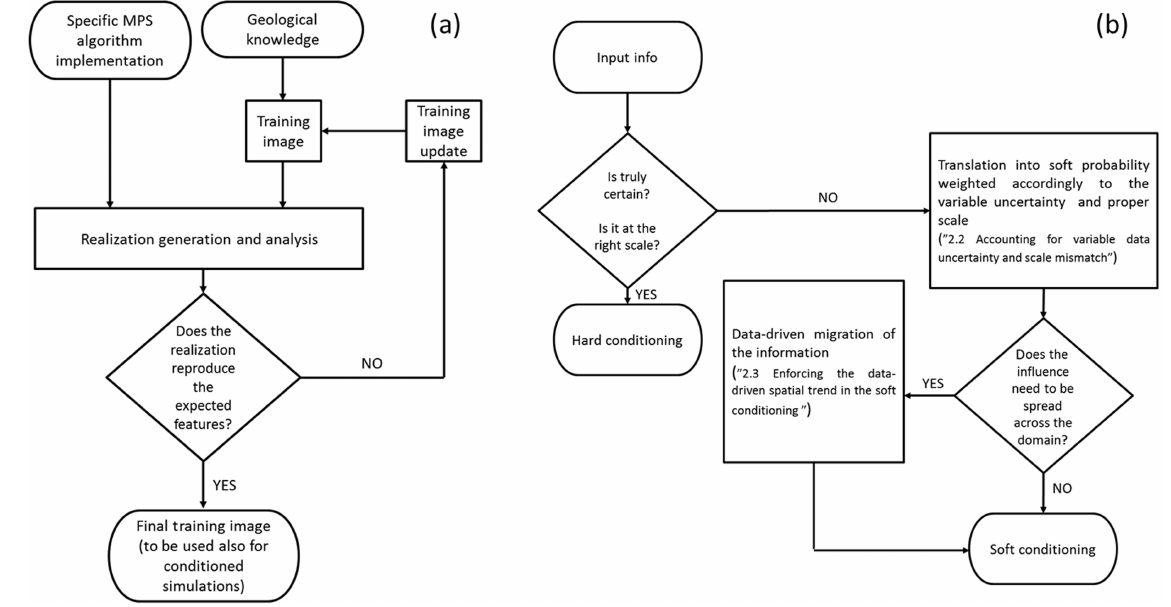
Figure 1. (a) Flowchart of the iterative TI construction (see Sect. 2.1) and (b) scheme of the proposed conditioning